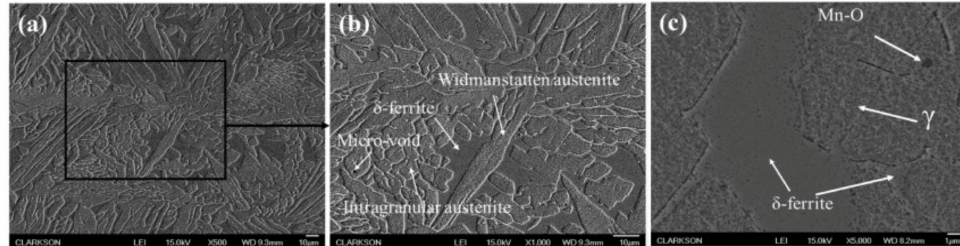
Figure 38. SEM image of one of the middle layer: ( a ) magnification × 500; ( b ) magnification × 1000; ( c ) magnification × 2000. Reprinted from Ref. [80].